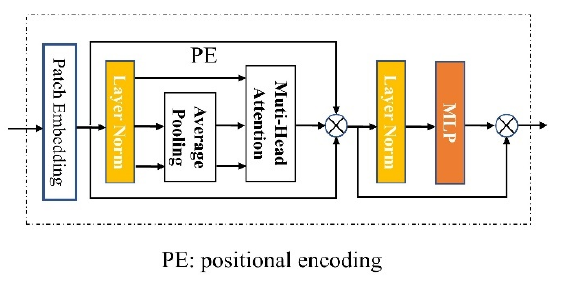
Figure 7. The design of Transformer Block, “PE” stands positional encoding.